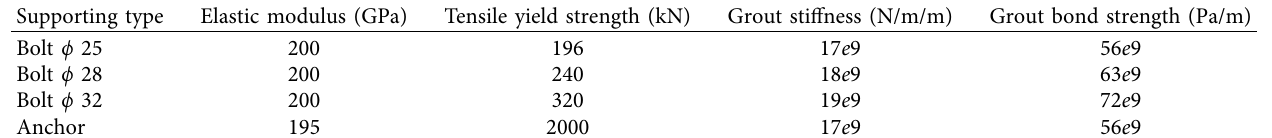
Table 5: Material property values used for rock supports in the numerical model. Supporting